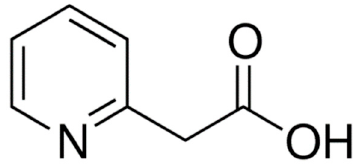
Figure 2. Structure of 2-pyridylacetic acid (2-PAA).